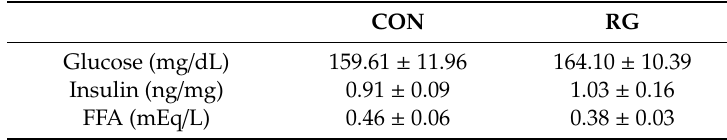
Table 4. Levels of glucose, insulin, and free fatty acids (FFAs) in plasma after 2 weeks of red ginseng (RG) intake.